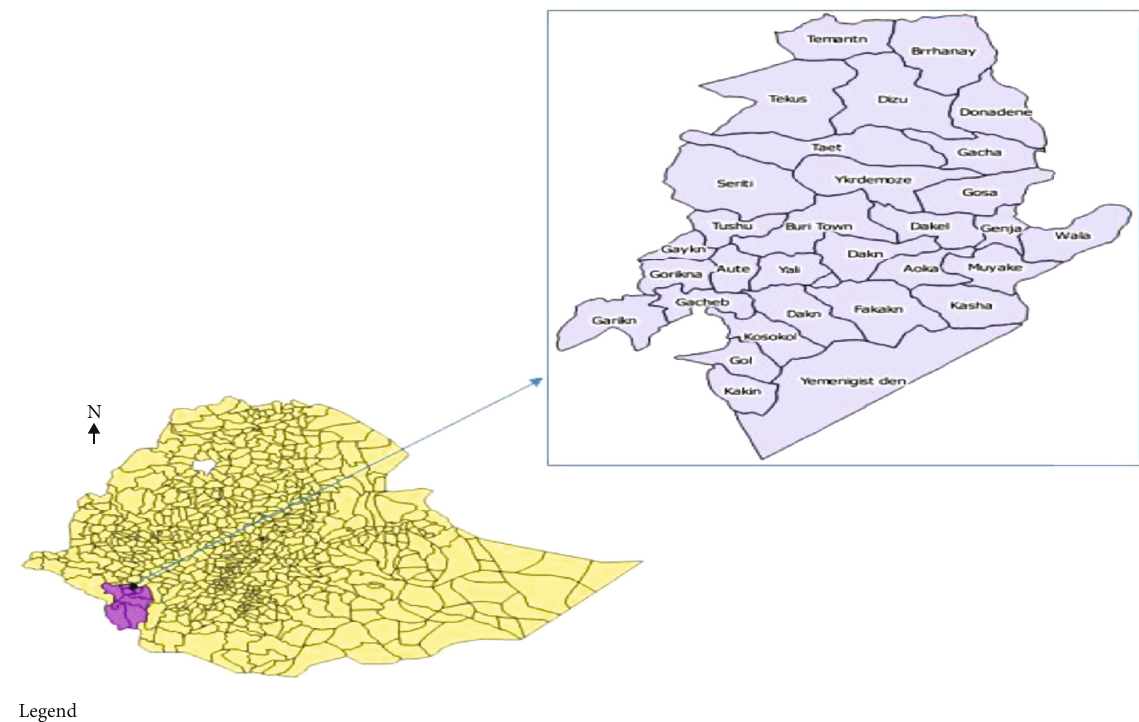
Figure 1: Map of Semen Bench